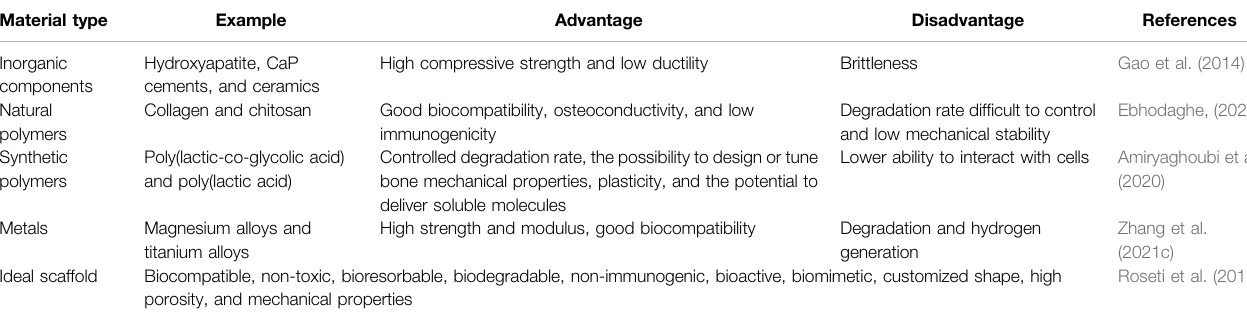
TABLE 1 | Brief comparison of bone engineering scaffold